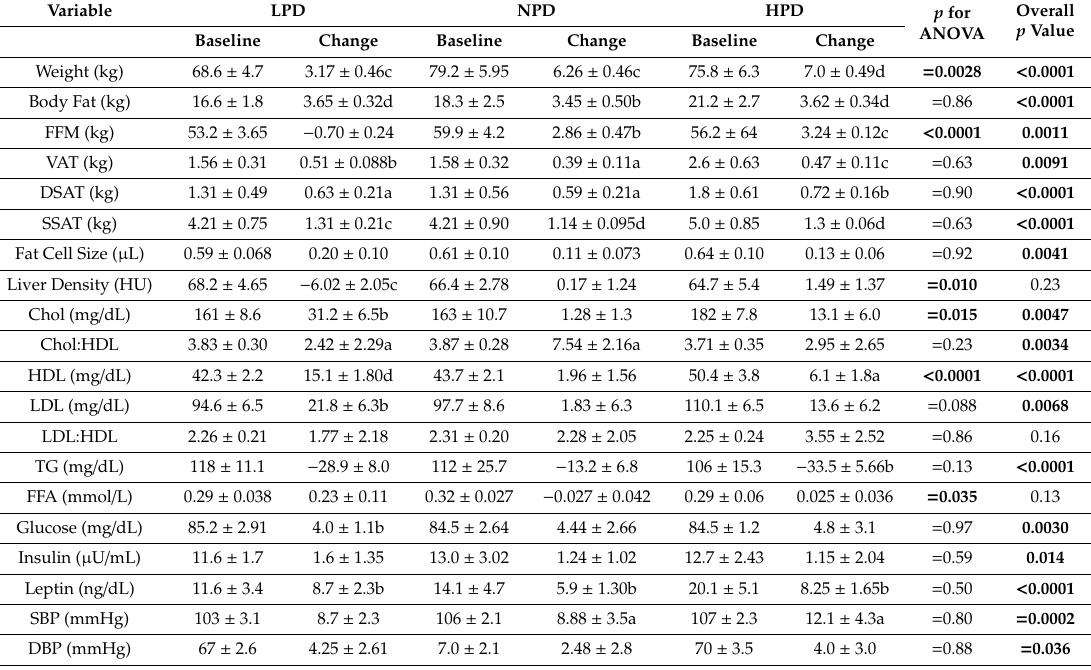
Table 2. Baseline and change from baseline by diet for the metabolic